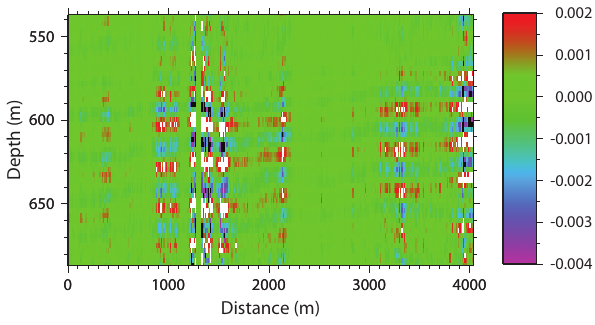
Fig. 8. Reflection coefficients calculated from a section of a 1km near-offset time-migrated seismic stack, centered on the thermoha- line staircase. Values at the high-gradient layers are larger than background noise and show a regular, lateral coherence through- out the profile. High values at 1400 and 4000m (masked white) correspond to errors caused by a diffraction in the sea floor, only partially corrected by the migration, and extremely low sea floor and multiple amplitudes